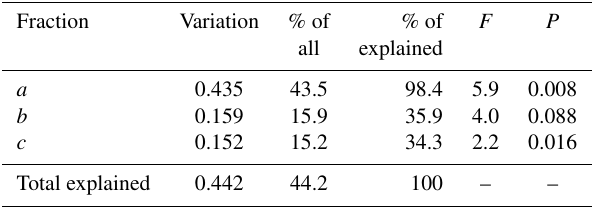
Table 3. The percentage of community characteristic variation ex- plained by different groups of environmental factors. Fraction Variation % of %